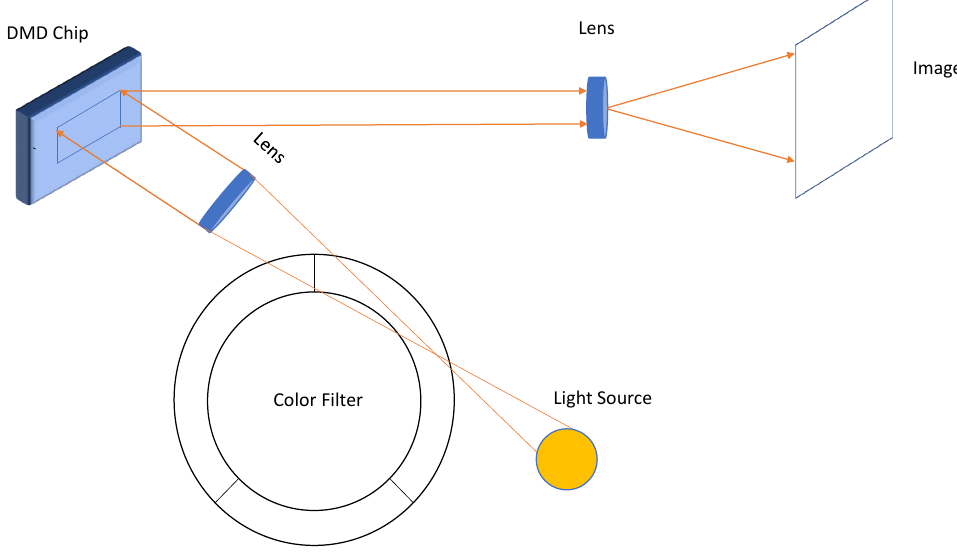
Figure 4. Configuration of a DLP